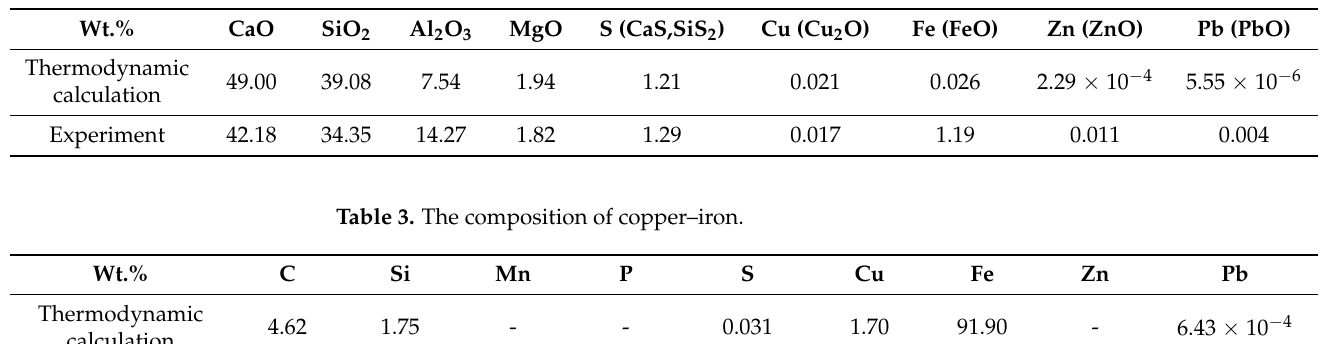
Figure 12. The phase analysis results of tailings. Table 2. The composition of tailings.